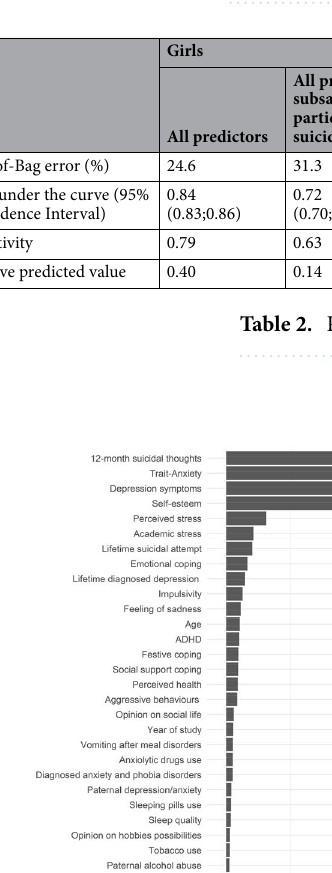
Figure 1. Area-under-the-curve plots of the sensitivity and specificity of random forests predictive models for suicidal thoughts and behaviours, stratified by gender.